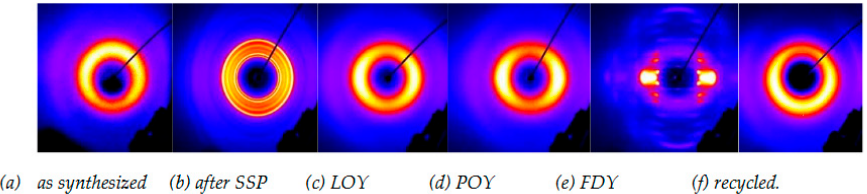
Figure 2. Characteristic X-ray images of the individual process steps: PEF-03 ( a ) as synthesized, ( b ) Granules after SSP ( c ) LOY yarn as spun ( d ) POY yarn as spun, ( e ) FDY drawn yarn, and ( f ) recycled PEF polymer.